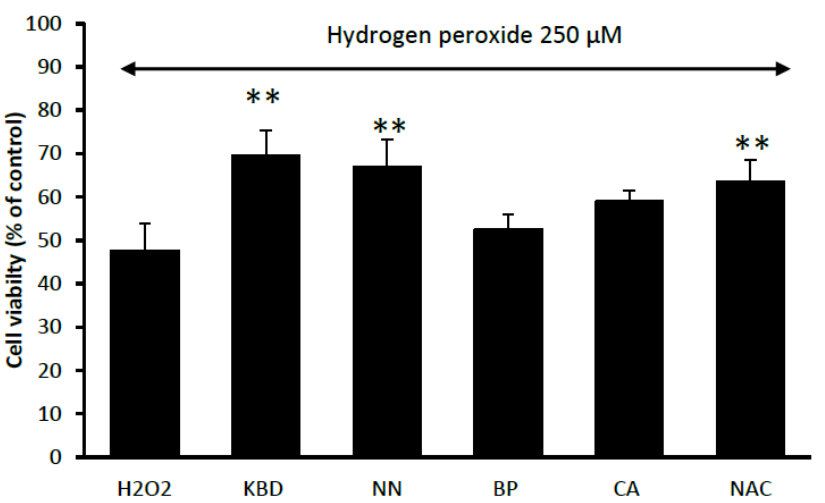
Figure 4. Effect of the KBD 100 μg/ mL and its component extracts ( Nelumbo nucifera (NN), Piper nigrum Figure 4. E ff ect of the KBD 100 µ g / mL and its component extracts ( Nelumbo nucifera (NN), Piper nigrum (BP), and Centella asiatica (CA) at 35 µ g / mL on H 2 O 2 -induced oxidative cell damage in neuroblastoma (BP), and Centella asiatica (CA) at 35 μg/mL on H 2 O 2 -induced oxidative cell damage in neuroblastoma cells . N -acetyl cysteine (NAC) at 100 µ g / mL was used as a reference standard. Data are means ± SD ( n cells . N -acetyl cysteine (NAC) at 100 µg/mL was used as a reference standard. Data are means ± SD = 5) ** p < 0.01 as compared with the H ( n = 5) ** p < 0.01 as compared with the H 2 O 2 -treated control group. 2 O 2 -treated control